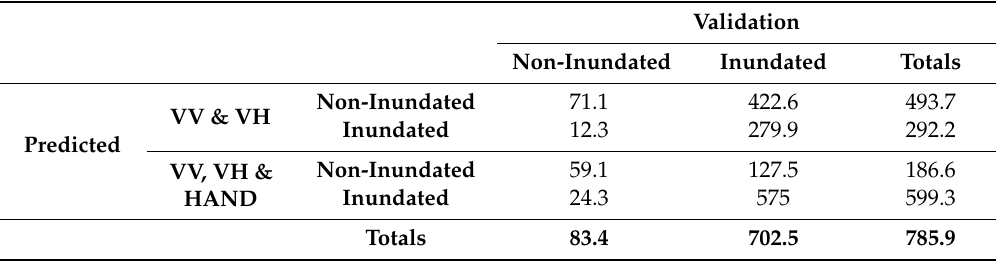
Table 4. Confusion matrix comparing primary metrics in pixels (1000’s) for both feature